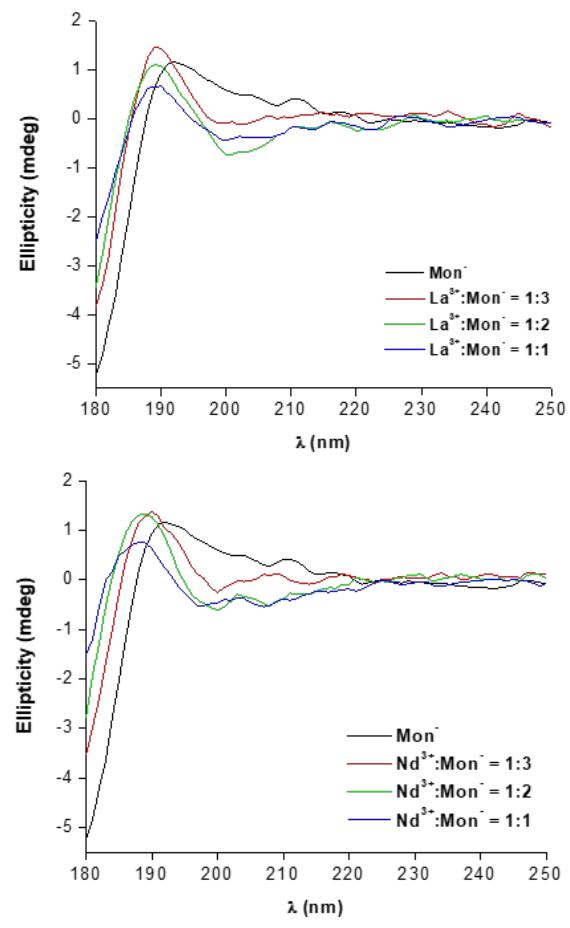
Figure 4: SRCD spectra of observed complex species at certain metal-to-ligand molar